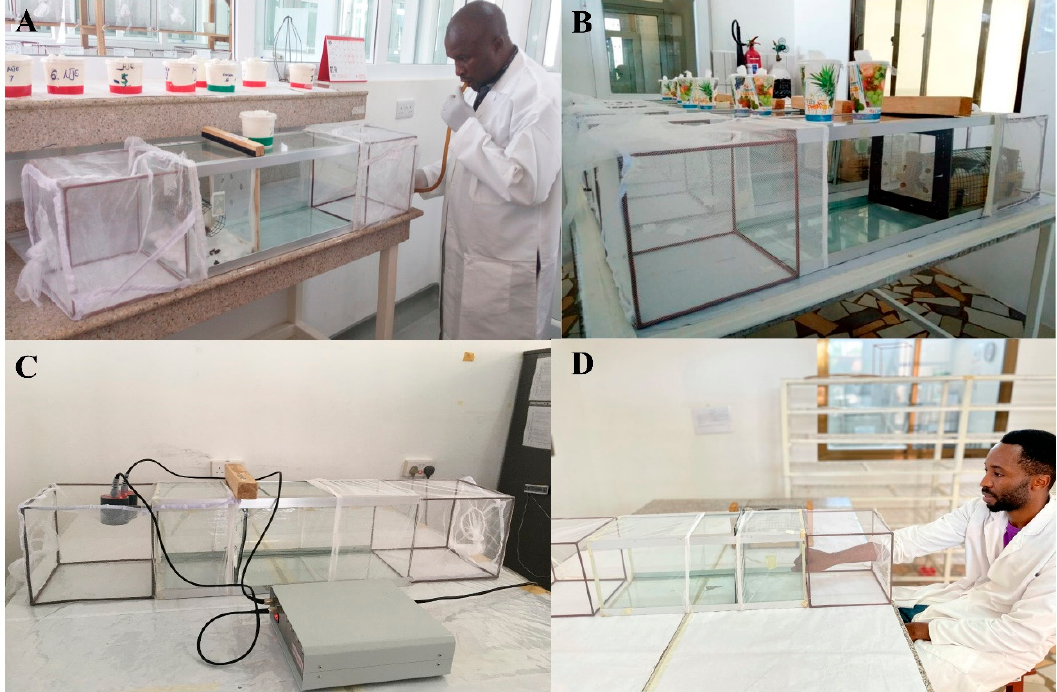
Figure 1. WHO tunnels for comparison of baits: ( A ) Conduct of standard WHO Tunnel with the bait chamber to the left of the picture and mosquitoes being placed into the longer end of the chamber; ( B ) Rabbit—in Experiments 1–4; ( C ) Hemotek ® membrane—in Experiment 1 and 4; and ( D ) Human arm—in Experiment 1.